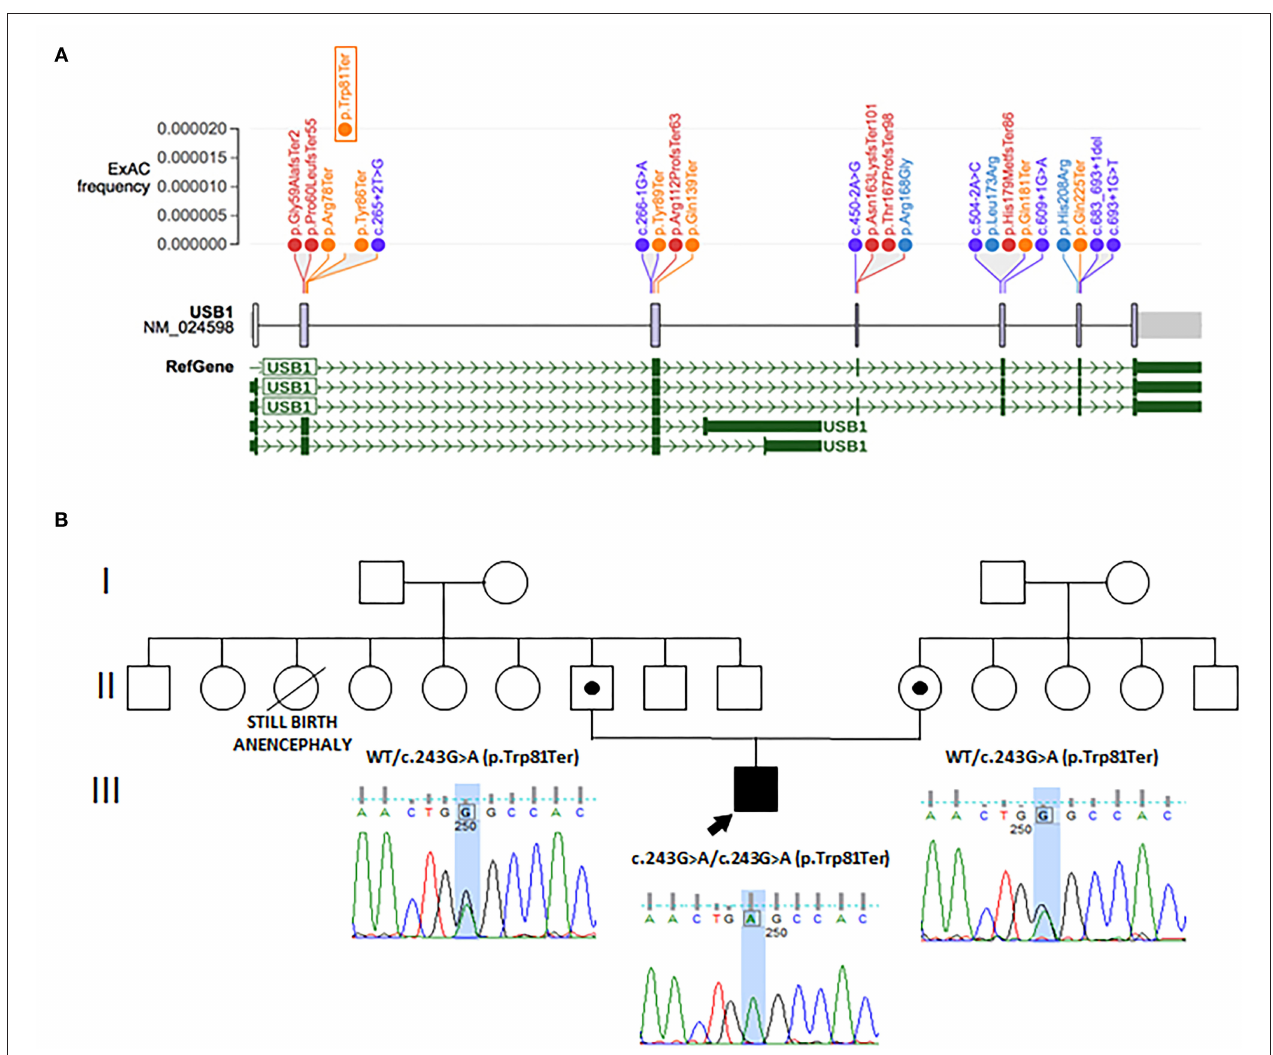
FIGURE 1 | (A) Schematic representation of intragenic mutations of USB1 . Nonsense variants are in orange, frameshift in red, splicing in violet, and missense variants in blue. Protein domains are in gray and refer to HVSL, uncharacterized conserved protein. All variants were extrapolated from ClinVar (RefSeq NM_024598.3). They are distributed according to their ExAc frequency (gnomad.broadinstitute.org). The mutation identified in our proband is framed. (B) Family tree, with electropherogram results of affected patient and